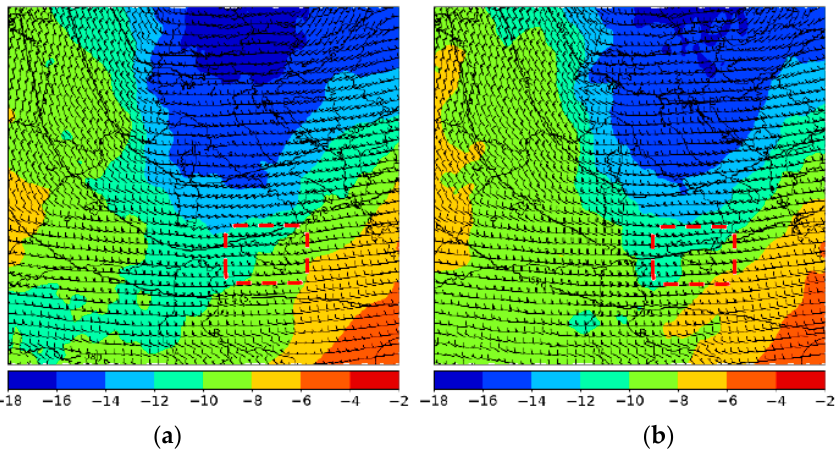
Figure 2. ECMWF-HRES analysis: 500 hPa geopotential height (dm, contours), temperature (°C) and wind (barbs) at 12:00 UTC ( a ) and 15:00 UTC ( b ) on 15 July. The red dashed box identifies the position of Sicily.